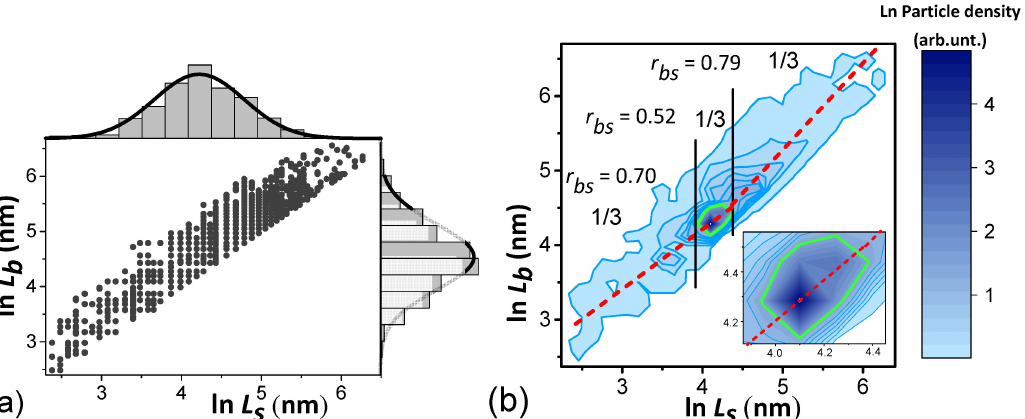
Figure 9. ( a ) Correlation cloud of transverse and longitudinal sizes L s and L b of LiFePO 4 for 4326 par- ticles and the corresponding marginal functions of their distributions fitted with Lognormal functions. ( b ) Particle-density isolines map divided into parts by vertical straight lines with small, intermediate and large particles 1/3 of their total; red dotted lines—smoothed average values. The correlation coefficients of these parts are indicated; the inset shows an enlarged part near the particle density